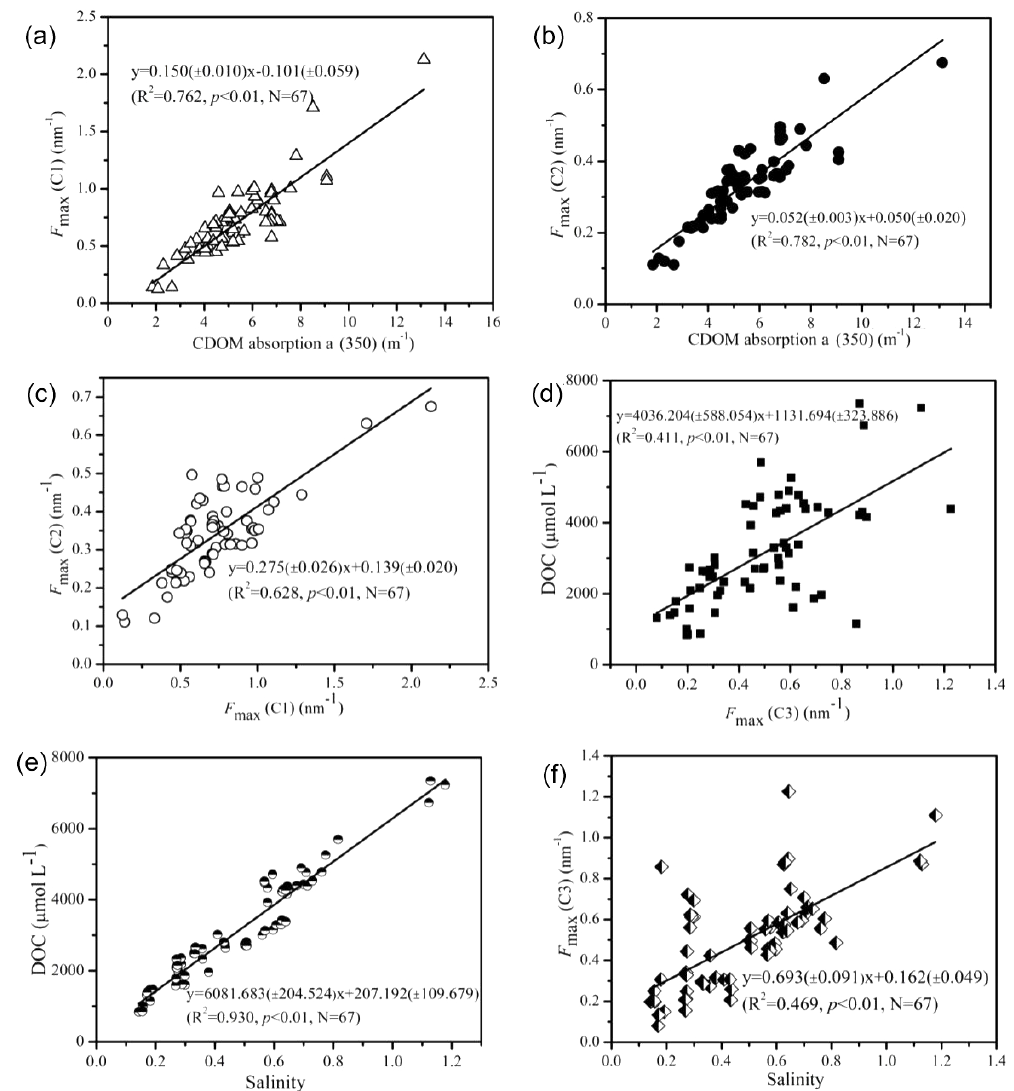
Figure 4. Relationships between CDOM absorption coefficient a (350) with (a) F max (C1), (b) with F max (C2), (c) peak F max (C1) vs. F max (C2), (d) peak F max (C3) vs. DOC, (e) salinity vs. DOC, (f) salinity vs. F max